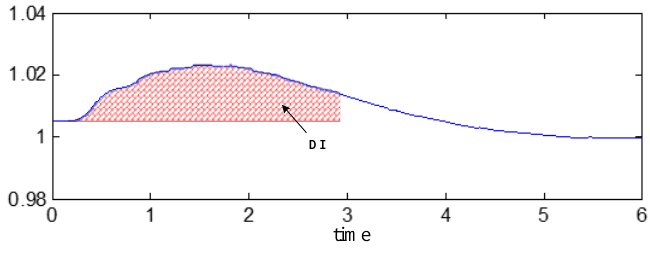
Figure 1. Illustration of DI .